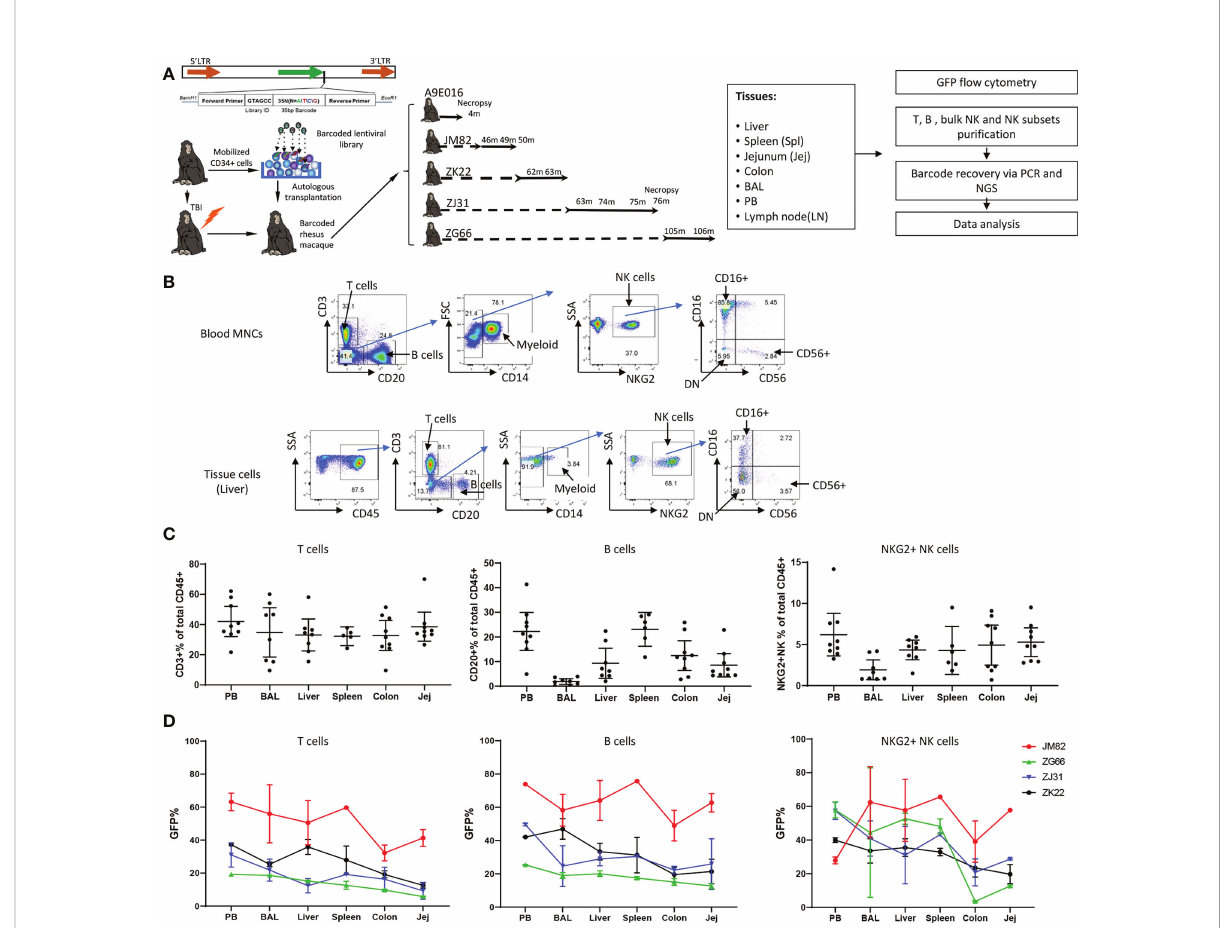
FIGURE 1 Experimental design, tissue and blood immune cell phenotyping and GFP marking levels (A) Experimental design. Peripheral blood (PB) and tissue samples including liver, spleen, jejunum, colon, lymph nodes and bronchoalveolar lavage (BAL) cells were collected at the speci fi ed time points post-transplantation from rhesus macaques transplanted with autologous CD34+ hematopoietic stem and progenitor cells (HSPCs) transduced with a high diversity barcoded lentiviral library. B cells, T cells, NK cells and NK cell subsets were analyzed for GFP expression and sorted via fl ow cytometry for barcode retrieval. (B) Representative fl ow cytometric gating strategies for puri fi cation of T cells, B cells, myeloid CD14+ cells and NK cells/NK cell subsets from PB (upper panel) and liver (lower panel). For all tissue samples, mononuclear cells were fi rst gated on CD45+ cells before analysis and sorting based on hematopoietic lineage surface markers. (C) The percentage of CD3+ T cells (left panel), CD20+ B cells (middle panel) and CD3-CD20-CD14-NKG2+ NK cells (right panel) within the total CD45+ cells in tissues and mononuclear cells in PB. Jej-jejunum; Spl-spleen. All samples collected from animals from ZK22, JM82, ZJ31 and ZG66 are included. (D) The % GFP-expressing cells within CD3+ T cells (left panel), CD20+ B cells (middle panel) and CD3-CD20-CD14-NKG2+ NK cells (right panel) in PB and tissues (liver, spleen, colon, BAL and jejunum). Each line represents all data from an individual monkey as speci fi ed on right of each